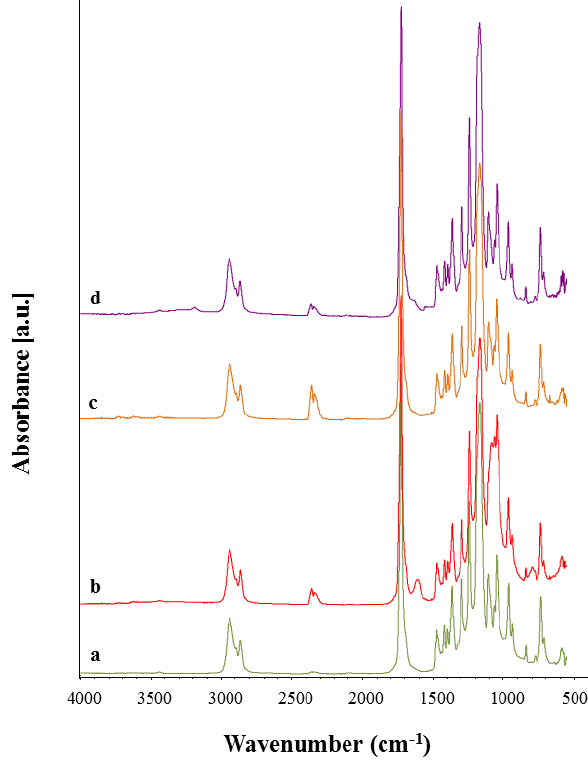
Figure 10. ATR-FTIR spectra of neat PCL fibers ( a ) and composite PCL_Ca_MCM-41 fibers ( b ) before immersion in SBF solution and PCL_Ca_MCM-41 fibers after immersion in SBF solution for 1 day ( c ) and 7 days ( d ).